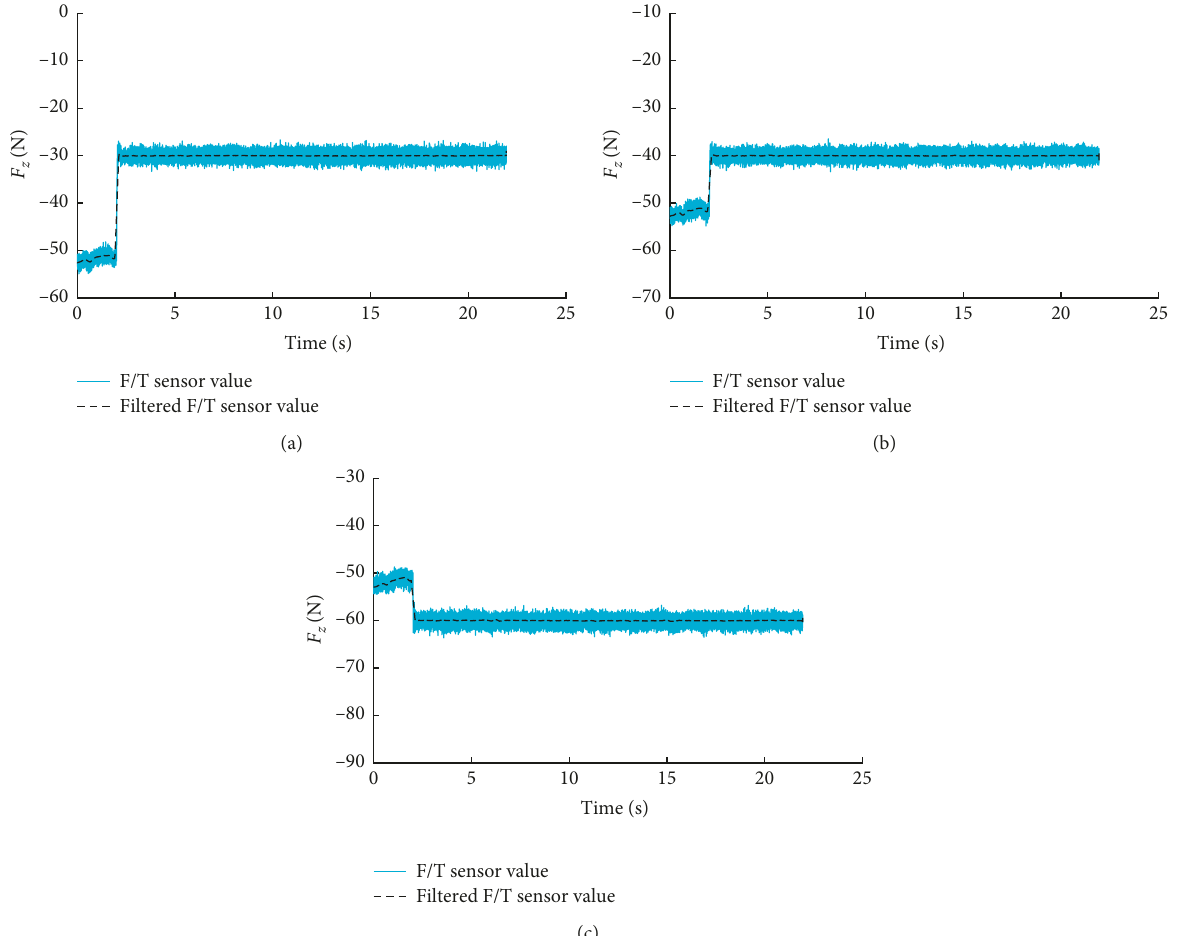
Figure 8: Force control performance of the hybrid sliding mode impedance controller in the Z direction with sensor values as control inputs. The desired force is set to (a) − 30N, (b) − 40N, and (c) − 60N.